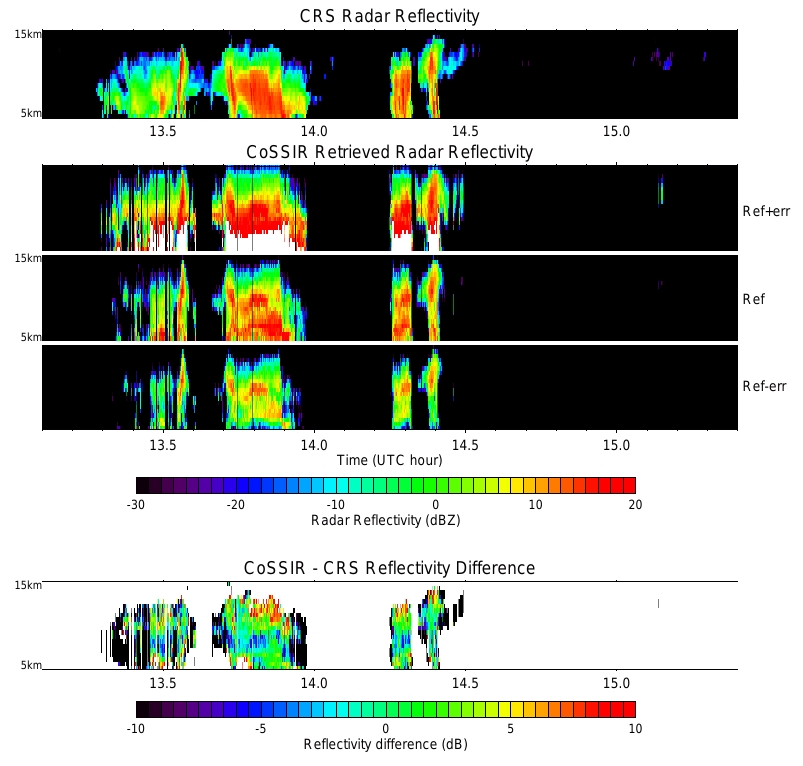
Fig. 17. A comparison of Cloud Radar System and CoSSIR retrieved 94GHz radar reflectivity profiles for CoSSIR determined cloudy columns. The 1- σ error range of the retrieved reflectivity profiles is shown with the images above and below the CoSSIR retrieved profiles. In the difference plot at the bottom, pixels with CRS reflectivity below its noise level or non-cloudy CoSSIR retrievals are white.